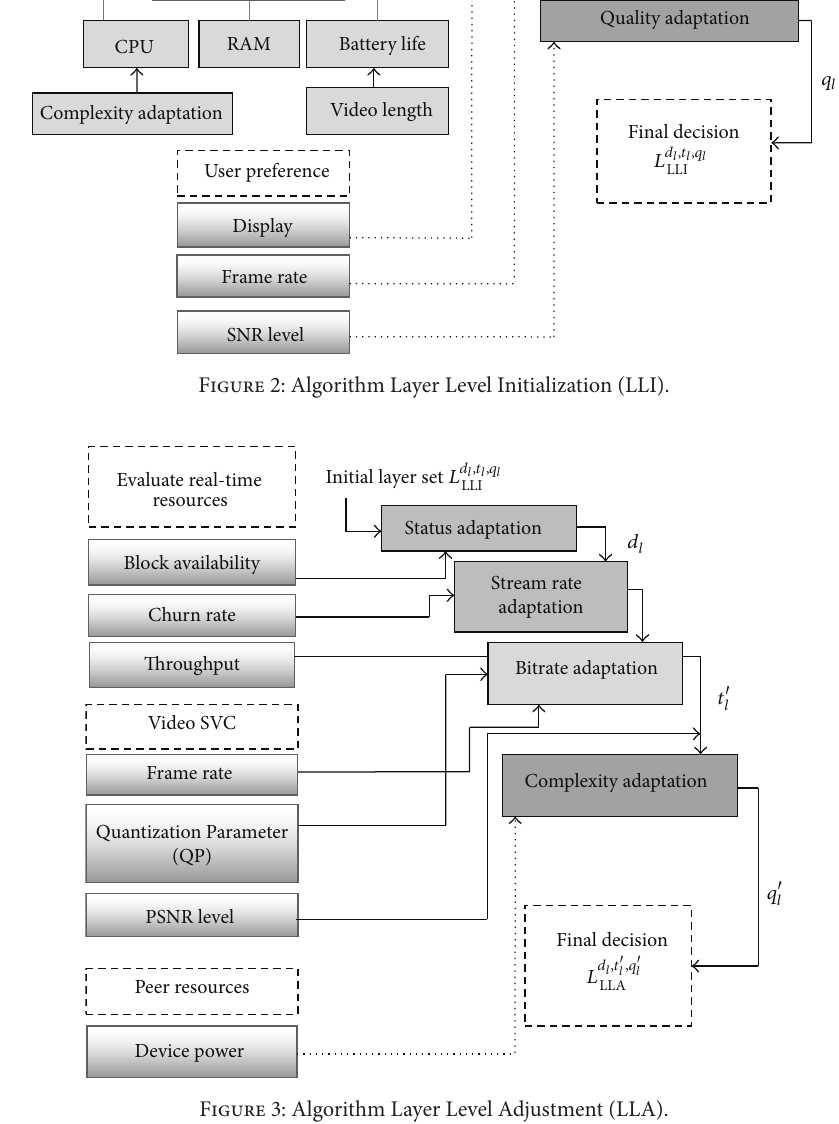
Figure 3: Algorithm Layer Level Adjustment